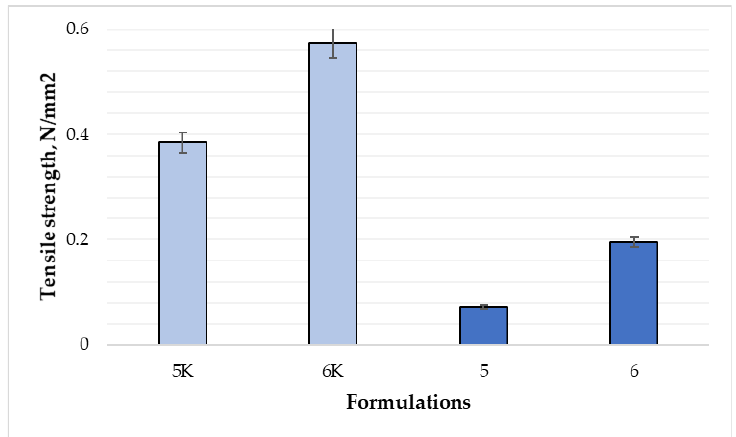
Figure 9. Pressure resistance test for films.